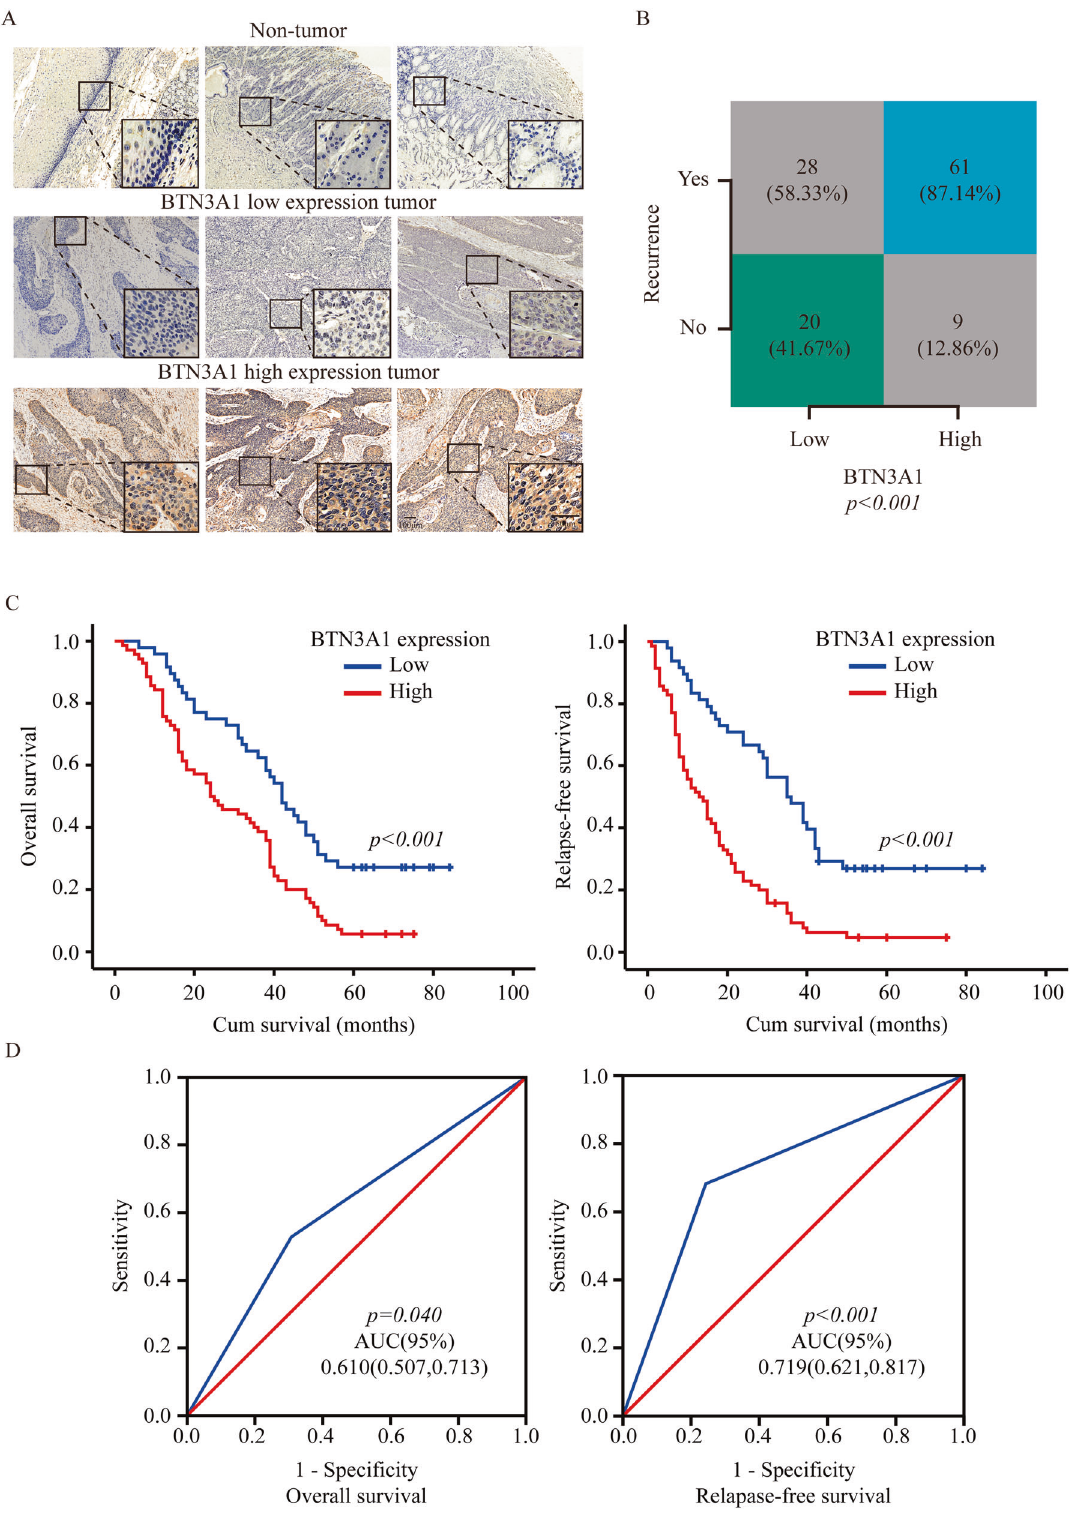
Fig. 1 BTN3A1 upregulation is associated with a poor prognosis in ESCC. A IHC Images of BTN3A1 staining in biopsy specimens from ESCC patients. Nuclei were counterstained with haematoxylin. Scale bar: 100 μ m, 50 μ m. B The relationship of BTN3A1 expression in the tumor and recurrence rate in ESCC patients samples, Chi-square test. C Kaplan – Meier curves for the OS and RFS of patients with high BTN3A1 expression ( n = 70) and low BTN3A1 expression ( n = 48). The p value was calculated using the log-rank test. D ROC curve analysis of OS and RFS. AUC values were estimated to assess the predictive ability of BTN3A1 expression.